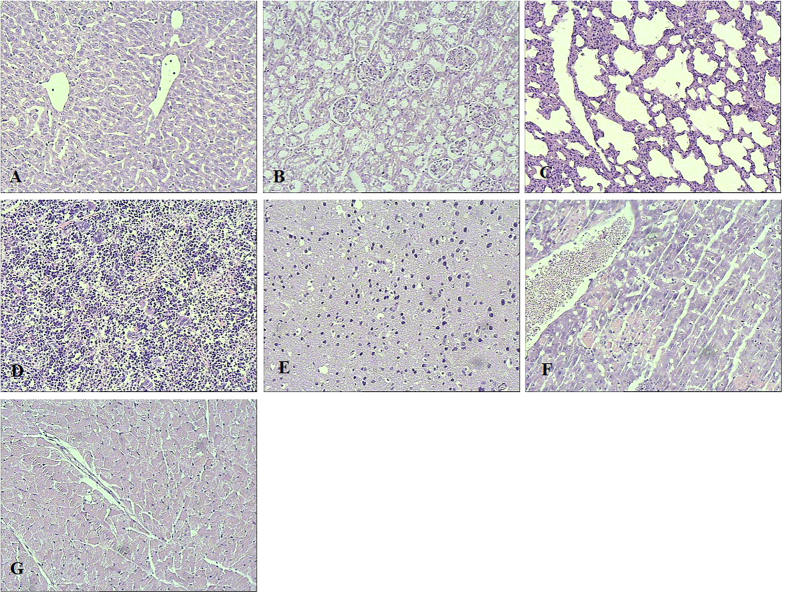
Histopathological findings of some organs from nude mice bearing xenograft hepatoma after different treatment (stained with HE, ×400).(A) liver. (B) kidney. (C) lung. (D) spleen. (E) brain. (F) heart. (G) pancreas.